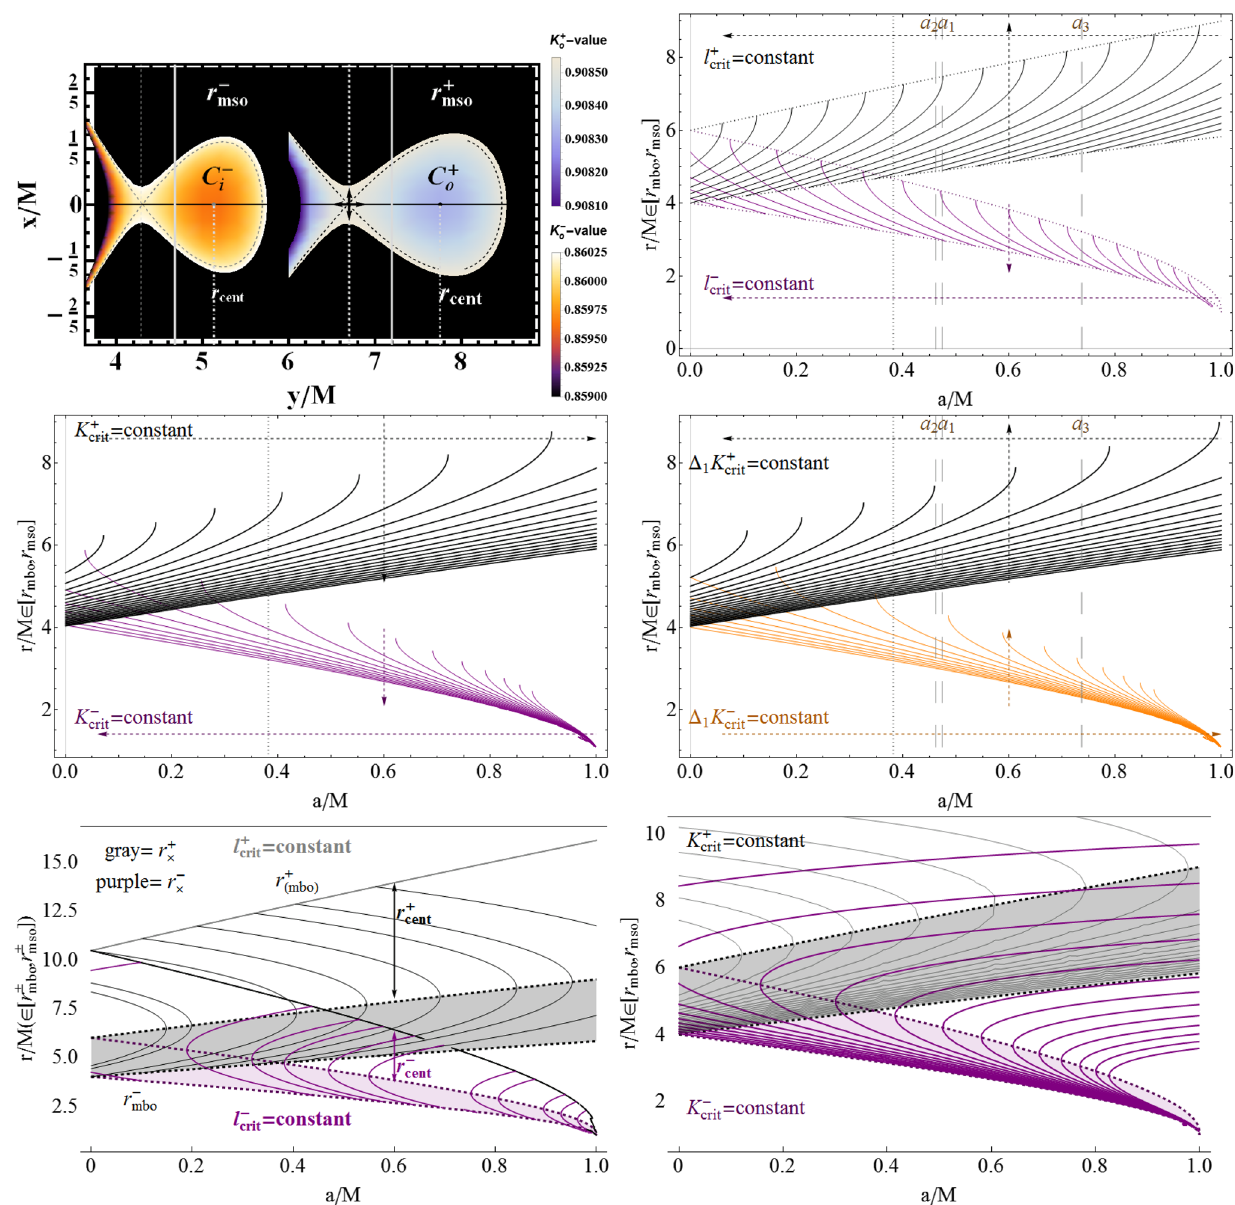
≡ ( K ± ( r ± ) − crit crit mbo mso ), , r ± ] , for corotat- mso mbo